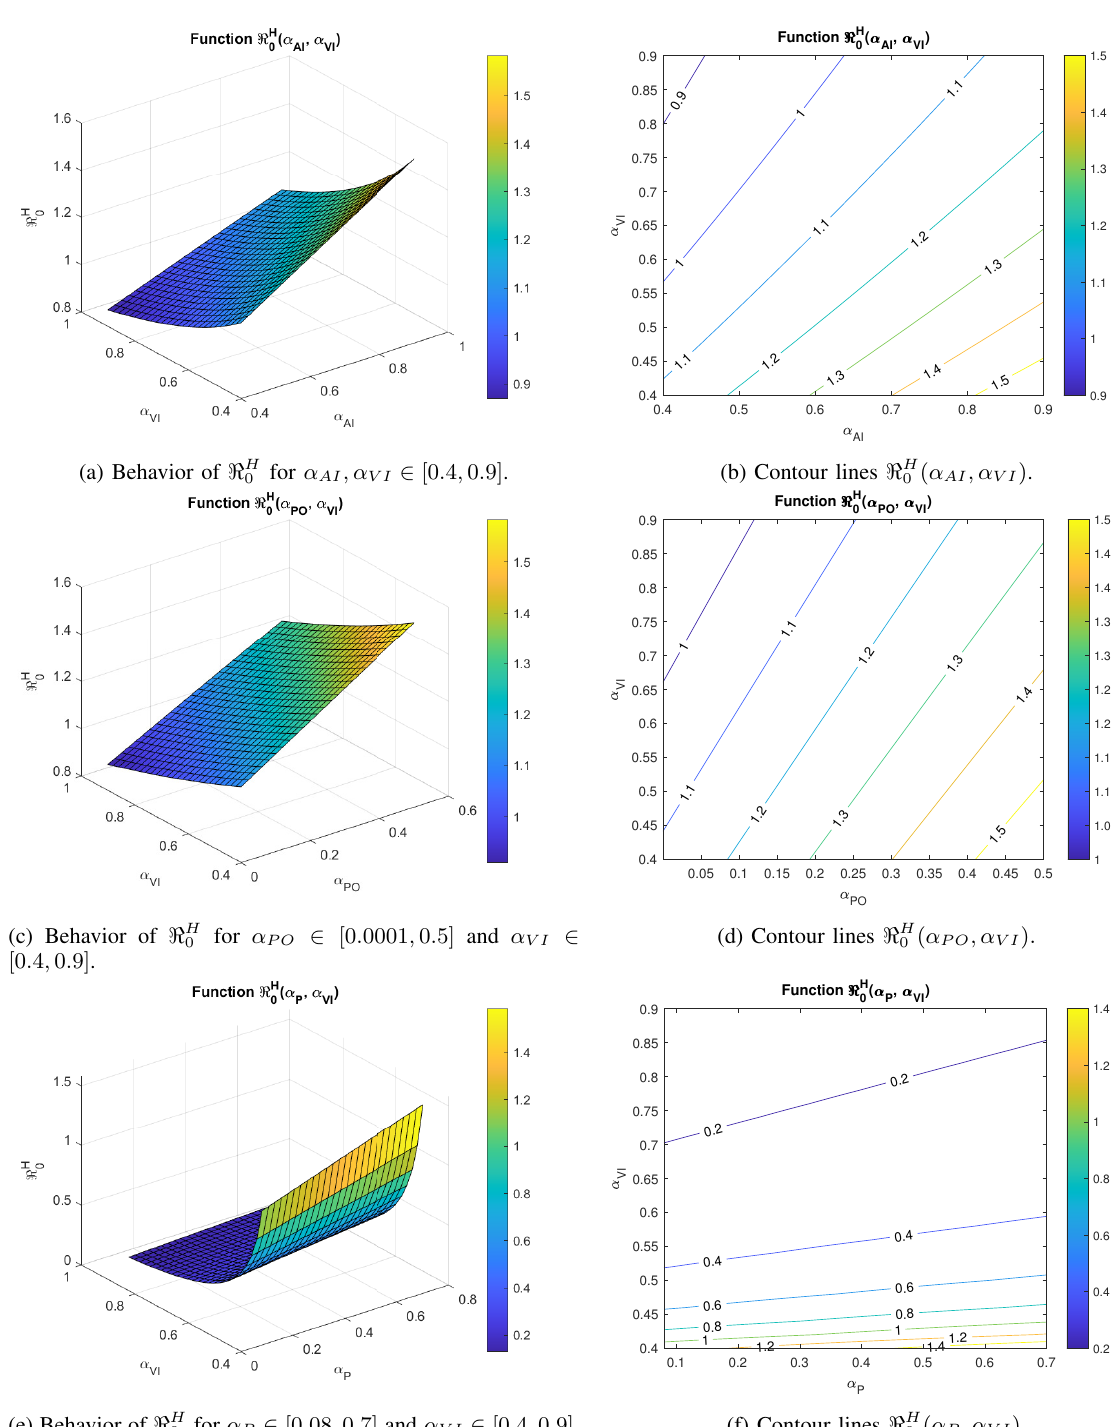
(e) Behavior of (cid:60) H 0 for α P ∈ [0 . 08 , 0 . 7] and α V I ∈ [0 . 4 , 0 . 9] . (f) Contour lines (cid:60) H 0 ( α P , α V I ) . Fig. 6: Graphical behavior for the variation of parameters associated with the use of PrEP, PEP, and undetectability in viral load for HIV and AIDS in the (cid:60) H 0